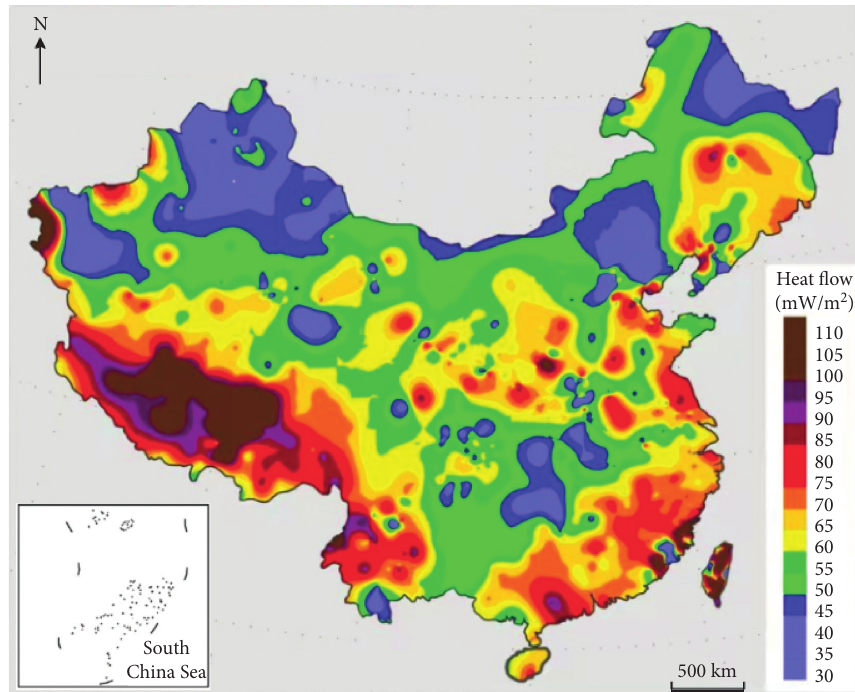
Figure 1: Heat flow map of China (cited from Hu et al., 2011